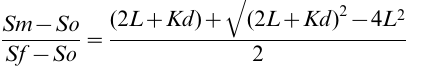
Figure S1 Numerical simulation of different A b catalytic intermediates in c -secretase reaction. (A-C). Computer